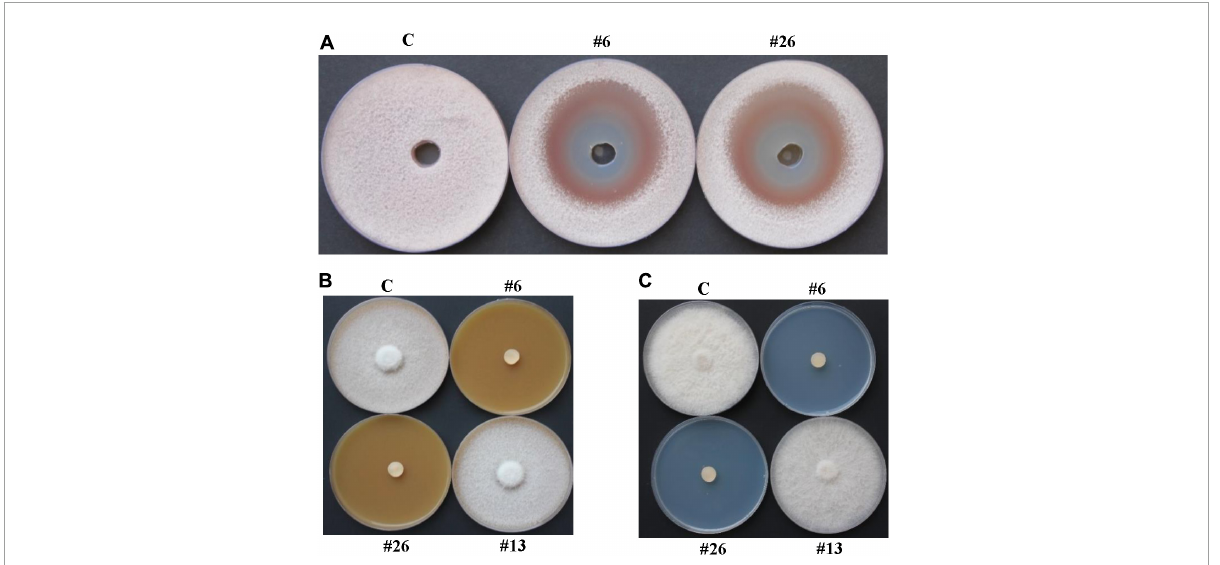
FIGURE4 In vitro antifungal activities of BCA candidates against Fusarium solani . Inhibition of F. solani mycelial growth by actinobacterial isolates #6 and #26 using (A) cup plate method on PDA; and dialysis membrane overlay technique using (B) FMEA or (C) CCA plates. In (A,B) , inhibition of F. solani mycelial growth was observed by the diffusible antifungal metabolite-producing isolates #6 and #26. In (C) , inhibition of F. solani mycelial growth was observed by the chitinase-producing isolates #6 and #26. In (A) , wells are inoculated with either filter-sterilized FMEB (C) , or filter-sterilized crude culture filtrates of isolates #16 or #26; while in (B,C) , FMEA or CCA plates are either colonized by no BCA, or isolates #6, #13 or #26. BCA, biological control; PDA, potato dextrose agar; FMEA/B, fish meal extract agar/broth; CCA, colloidal chitin agar; C, sterile non-inoculated PDA agar plug/filter-sterilized FMEB (negative control); #13, Streptomyces sp. (positive control): #6, Streptomyces tendae UAE1 (ACCD-non-producing BCA1); #26, Streptomyces violaceoruber UAE1 (ACCD-producing BCA2).